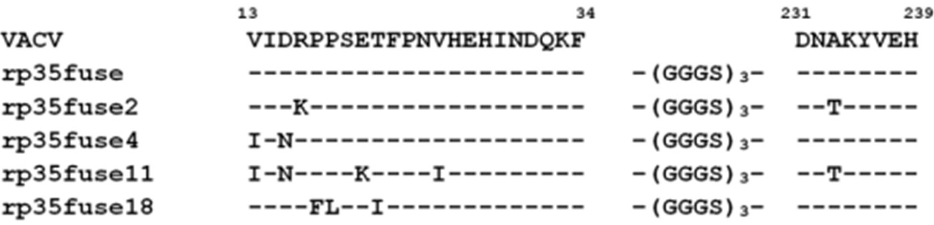
Figure 5. Alignment of rp35Δfuse mutant variants. Purified rp35Δfuse2, rp35Δfuse4, rp35Δfuse11, and rp35Δfuse18 proteins were sub-